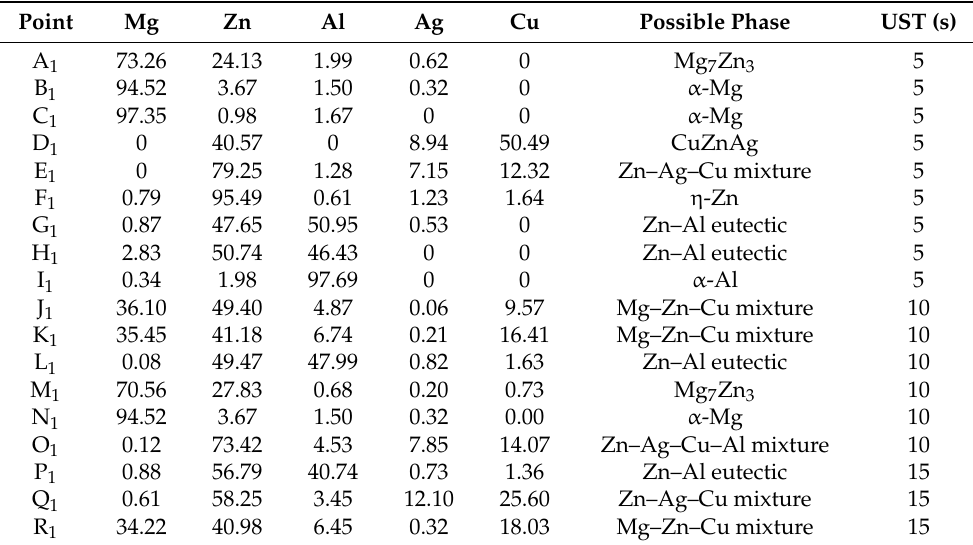
Table 1. Chemical composition in different regions shown in Figure 2